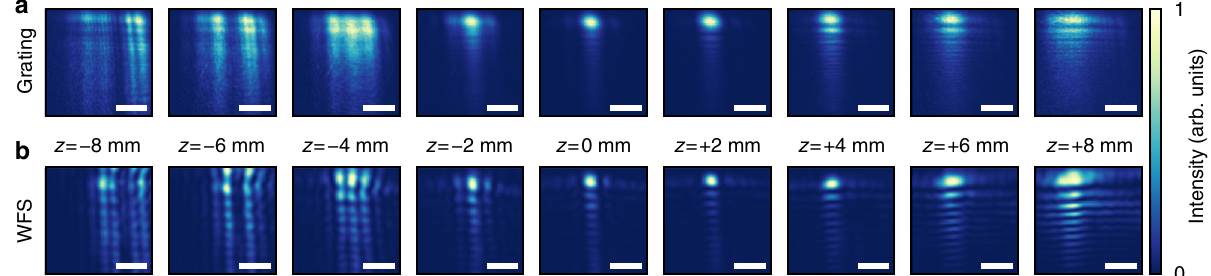
Fig. 5 Spatial fl uence distributions along the beam propagation axis. a Multi-shot image of the grating ’ s positive diffraction order. The fl uence distributions appear blurred due to spatial jitter. b Spatial fl uence distribution calculated from a single-shot wave-front sensor measurement. The position z of the sample plane is given relative to the nominal focus position. Note that all images are individually normalized. The peak intensity drops rapidly when the sample moves out of the focus position. Scale bars correspond to 10 μ